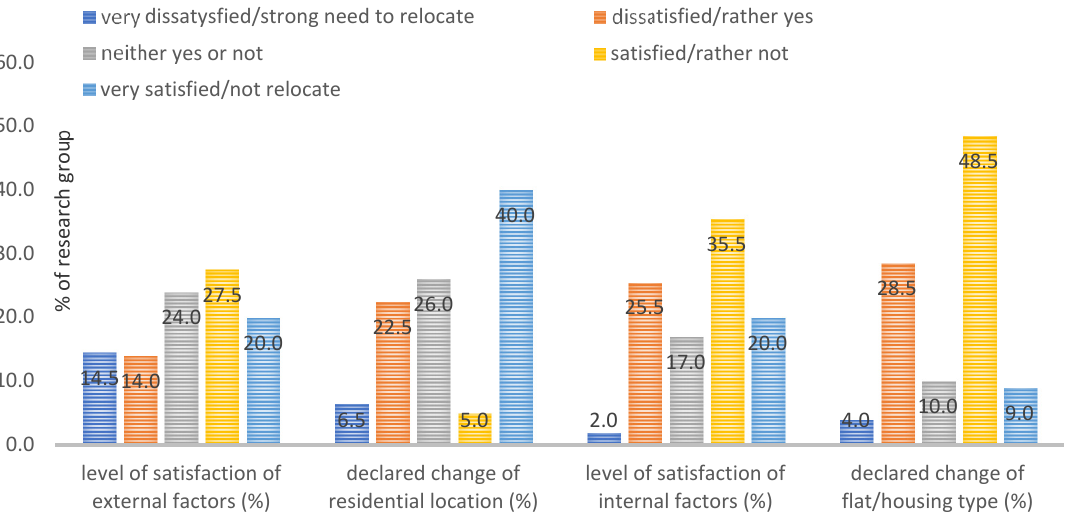
Figure 10. The level of satisfaction and the declaration of willingness to change the current residential location or housing type. Source: own study.